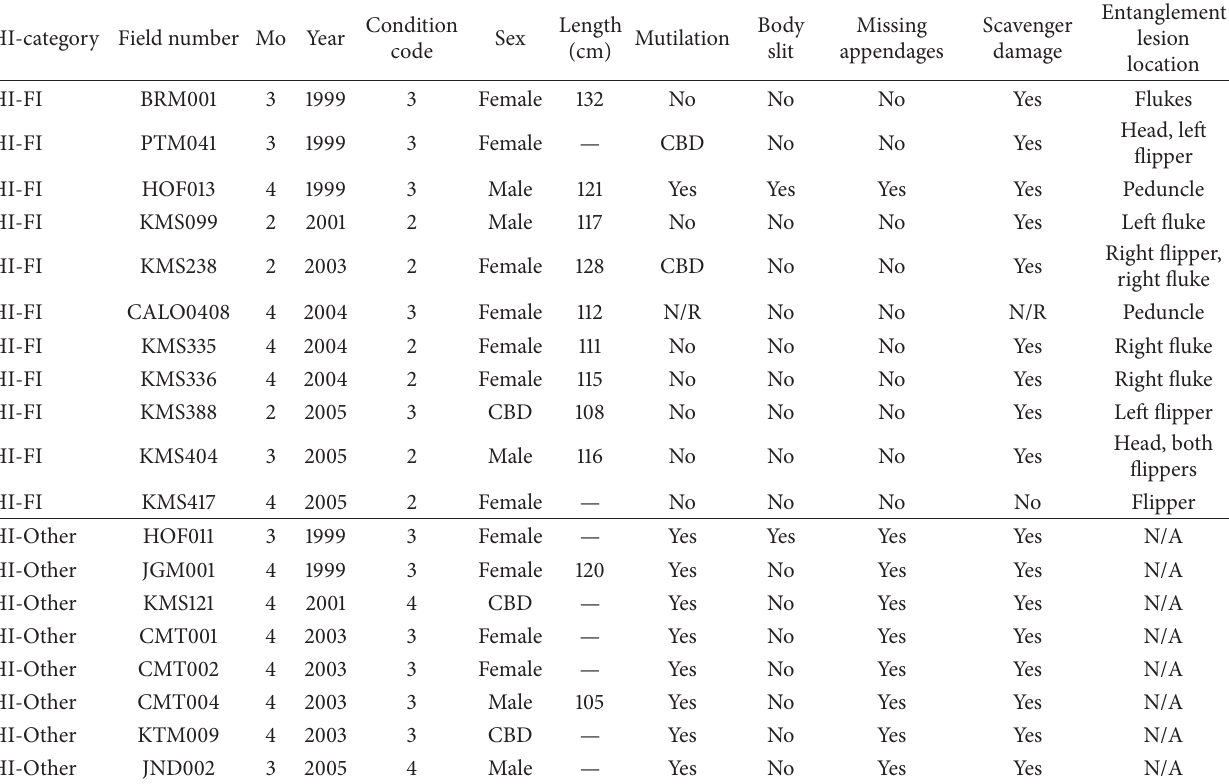
Table 1: Information for harbor porpoise strandings during 1997–2009 categorized as positive for human interactions (HI), either HI-FI (fishery interaction) or HI-Other (other evidence of HI). CBD: could not be